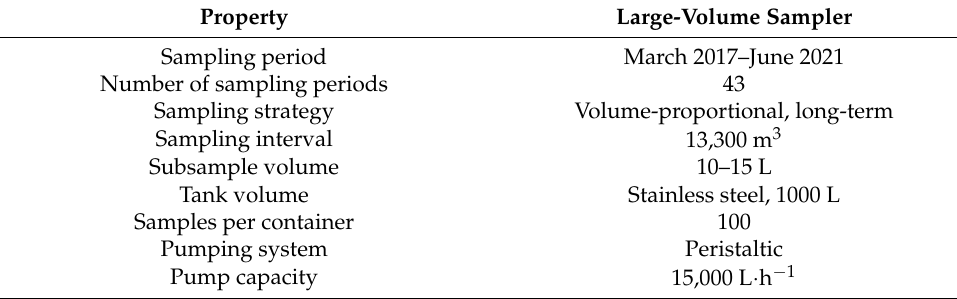
Table 1. Properties of the large-volume sampler at the Kraichbach